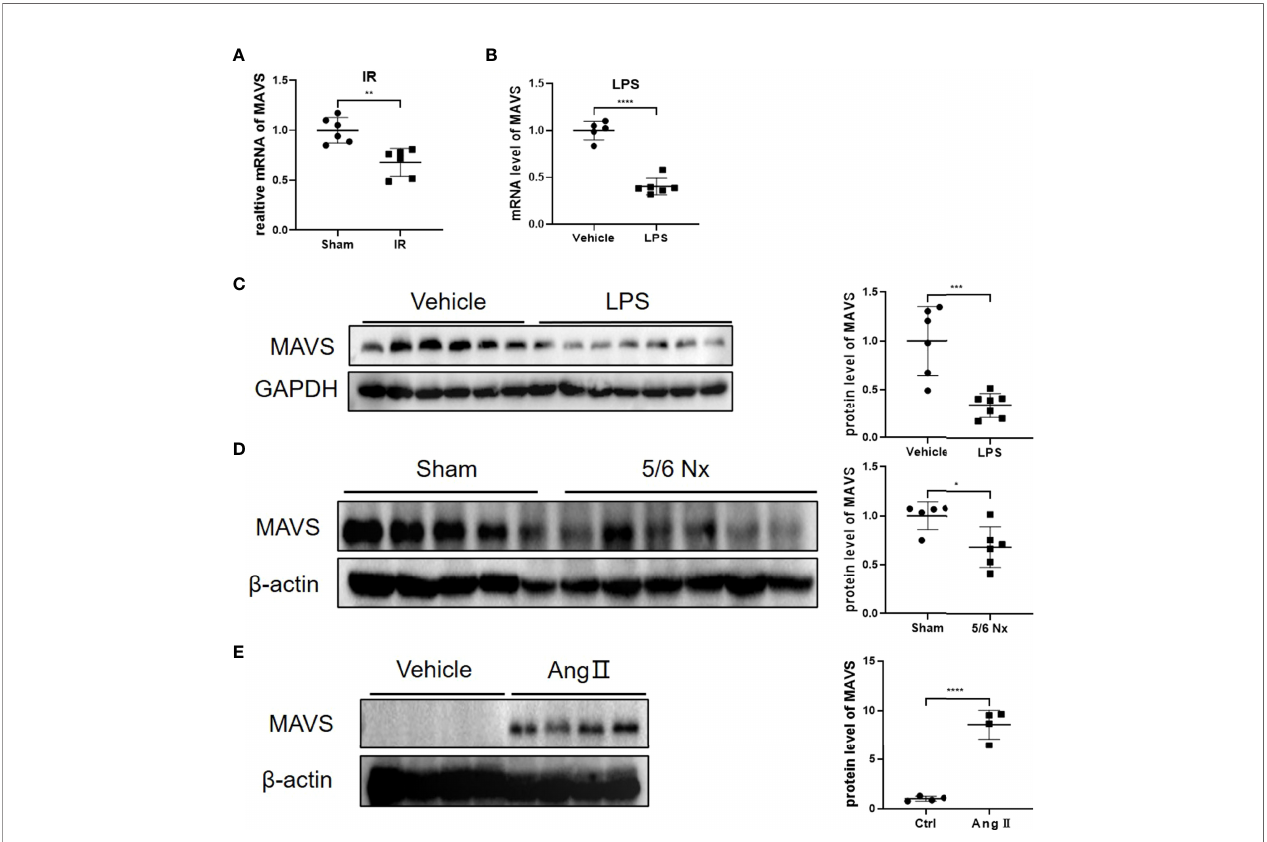
FIGURE 1 | Differential regulation of MAVS in animal models with non-hypertrophic and hypertrophic cardiac dysfunction. (A) . The data from GSE4105 illustrated that the MAVS expression (gene ID: 311430) was lower in rats challenged with cardiac ischemia-reperfusion injury (P=0.0019). (B) . The mRNA levels of MAVS in heart tissues of mice treated with lipopolysaccharide (LPS, 10mg/kg, 12 h) were signi fi cantly downregulated. (C) . Representative western blots of MAVS in LPS-treated hearts. Densitometry analysis of the western blots of MAVS. (D) . Representative western blots of MAVS in the hearts of mice subjected to 5/6Nx. Densitometry analysis of the western blots of MAVS. (E) . Representative western blots of MAVS in Angiotensin II (Ang II)-challenged mice hearts (Ang II, 1.4 mg/kg/day, 4 weeks). Densitometry analysis of the western blots of MAVS. The quantitative results are shown as means ± standard error of the mean (SEM) (*P < 0.05, **P < 0.01, ***P < 0.001 and ****P <